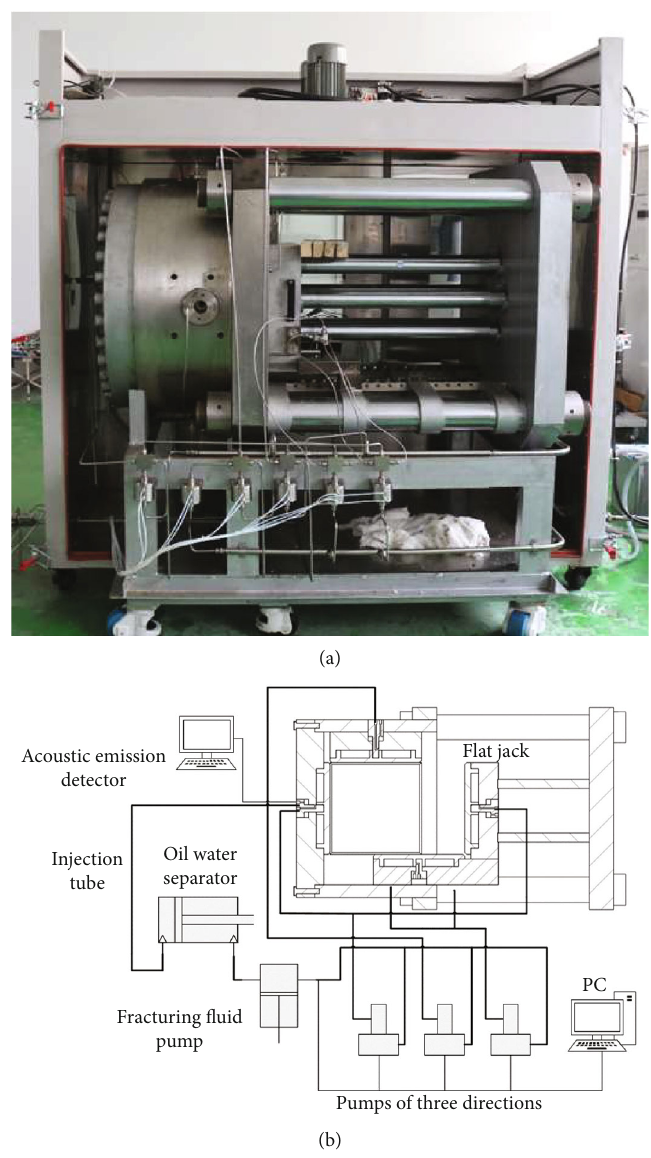
Figure 1: Schematics of (a) the HTHP fracture system and (b) the experiment setup. Table 1: Mechanical properties of the arti fi cial cement